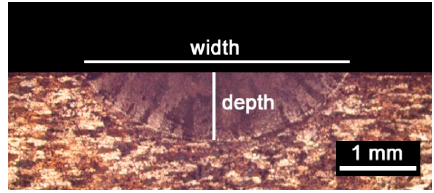
Figure 8. Width and depth of the fusion zone, macrograph resulting at speed of 6 mm/s, power of 2000 W.